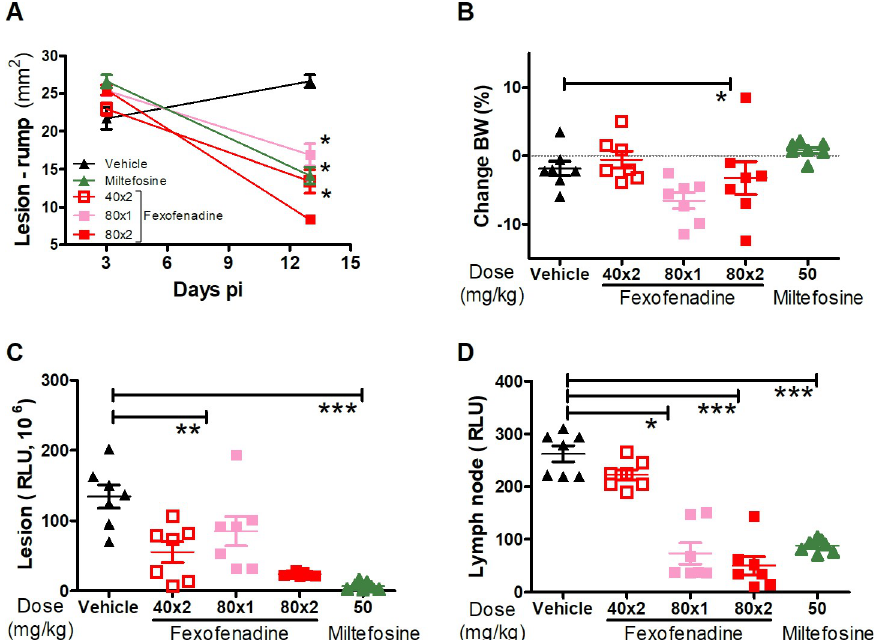
Fig 6. Evaluation of fexofenadine efficacy in BALB/c mice infected with L . major . Mice (n = 7) were infected ID with 10 7 metacyclic promastigotes of L . major transfected with the luciferase gene. Lesion size (area in mm2 = length x width) was measured using a digital caliper (A). Body weight change was used as a major sign of toxicity (B). The parasite load at the lesion site (C) and lymph nodes (D) was determined in vivo using the IVIS spectrum. Animals were treated PO with fexofenadine or vehicle (control) from day 3 to 10 p.i. The graphs show mean values and their standard deviation (SD). Representative data of 3 experiments. P values: � < 0.05; �� < 0.01; ��� < 0.001. The statistical significance of the data was determined using the t